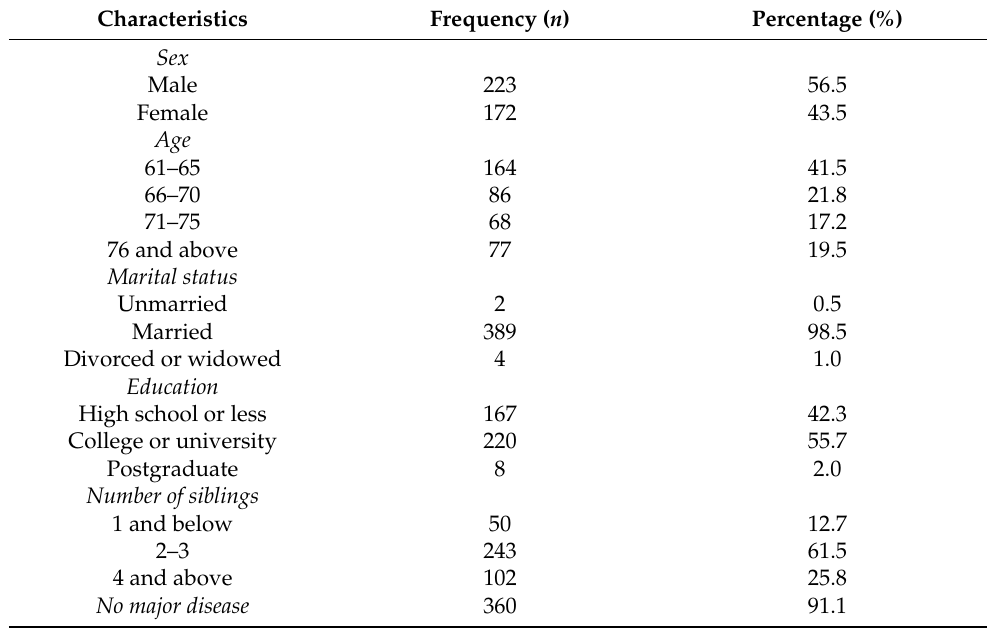
Table 1. Respondent profiles ( n = 395).